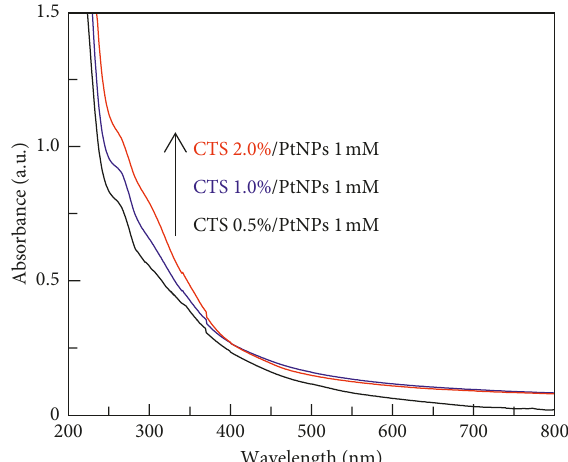
Figure 2: UV-Vis spectra of PtNPs/CTS solutions with different CTS concentrations.